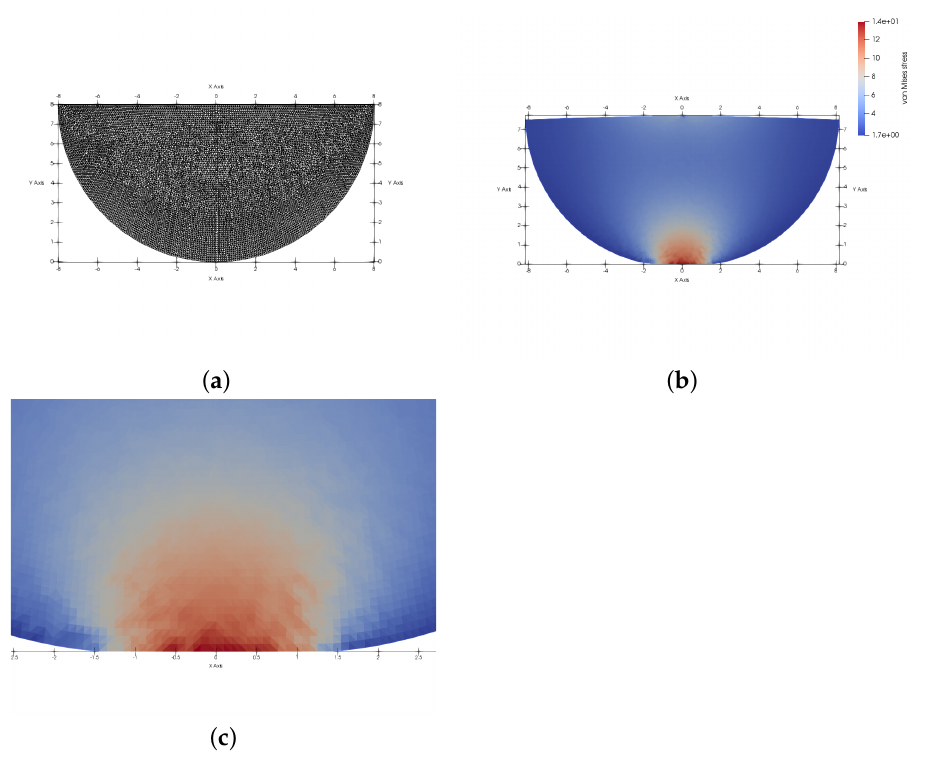
Figure 1. Hertz half ball: the undeformed mesh ( a ), the von Mises stress after compression ( b ) and a zoom of the contact zone ( c ).